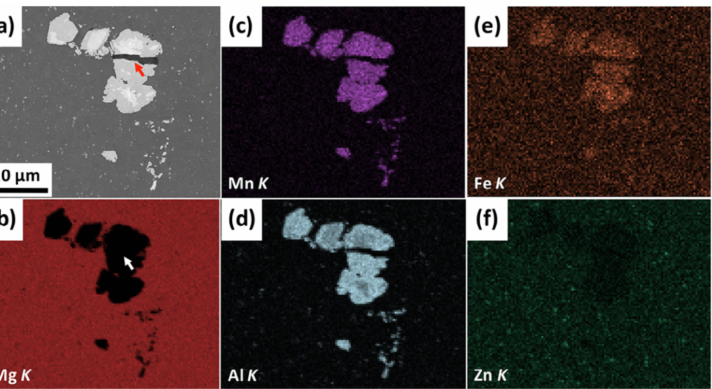
Figure 4. ( a ) Combined SEM/EDS map analysis of the AZ31B-4E Mg alloy, where: ( a ) SEM micro- graph of the investigated area of the as-received material, ( b ) EDS elemental map of Mg, ( c ) EDS elemental map of Mn, ( d ) EDS elemental map of Al, ( e ) EDS elemental map of Fe, and ( f ) EDS elemental map of Zn